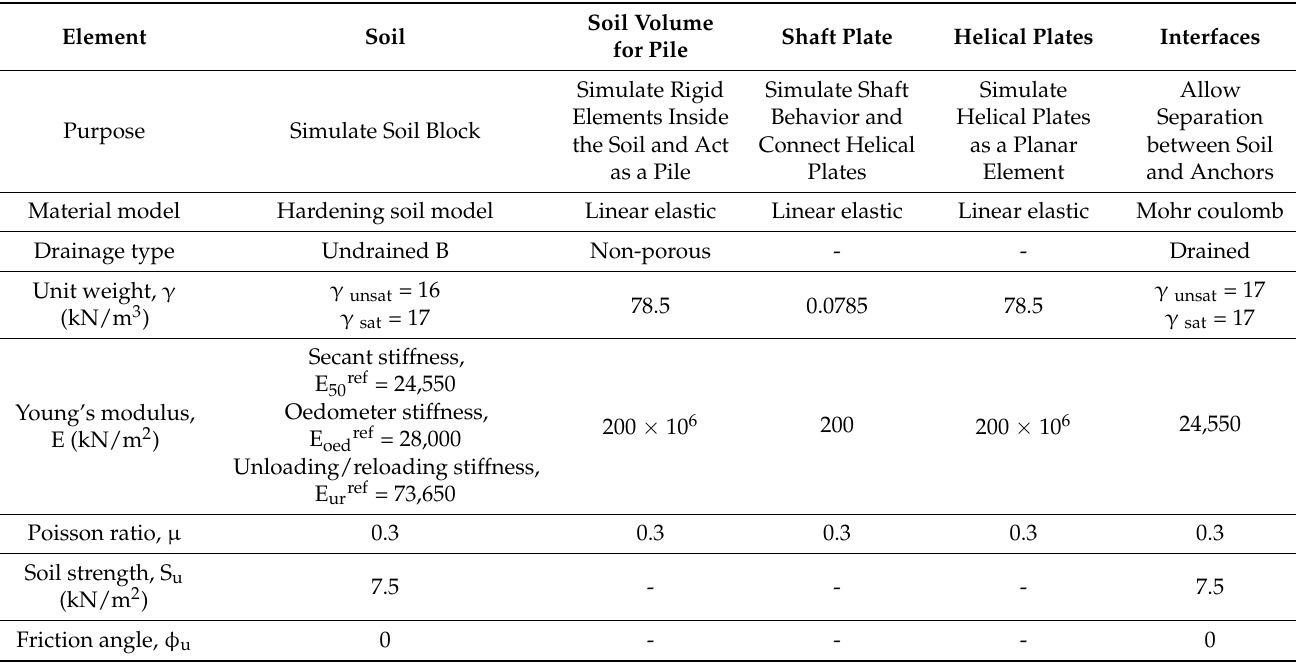
Table 2. Element parameters and properties to simulate helical anchor